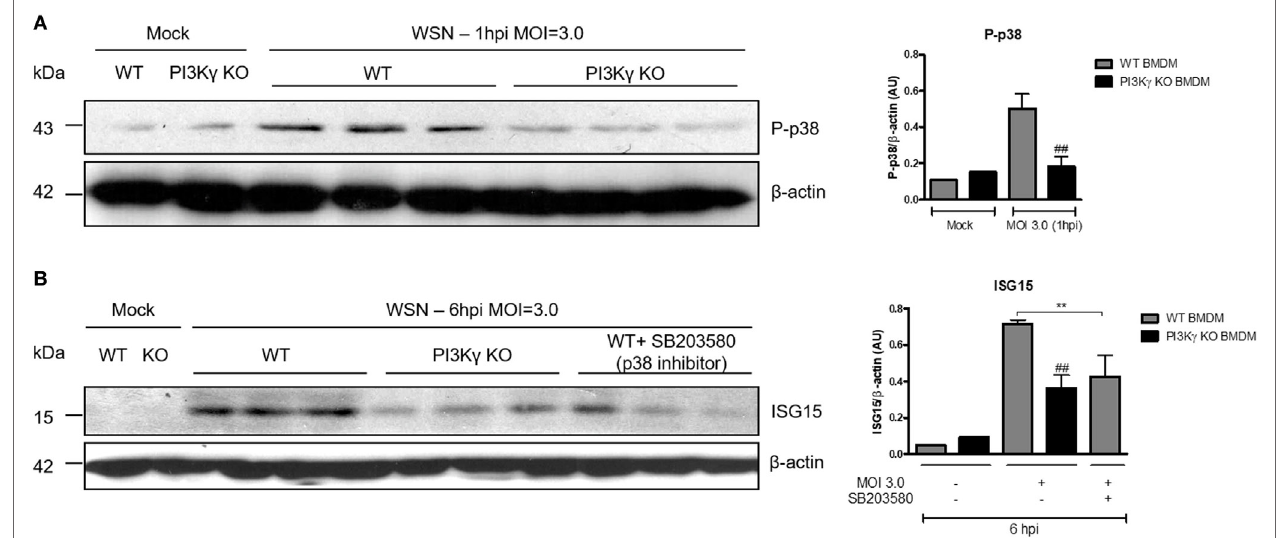
FigUre 4 | Phosphatidyl inositol 3 kinase-gamma (PI3K γ ) activation on bone marrow-derived macrophages (BMDM) leads to interferon-stimulated gene 15 (ISG15) production during influenza A virus infection in a p38-dependent way. BMDM from WT and PI3K γ knockout (KO) were infected with influenza WSN [multiplicity of infection (MOI): 3.0]. (a) One hour after infection, BMBM protein extracts were analyzed for p38 phosphorylation; β -actin was a loading control. (B) WT BMDM were pretreated with the p38 inhibitor SB203580 or vehicle and KO BMDM were treated with vehicle then infected with WSN (MOI: 3.0). ISG15 protein expression was assessed at 6 h after infection; β -actin was a loading control. Results are presented as mean ± SD. ** p < 0.01, when comparing WT-infected cells treated or not with SB203580; ## p < 0.01, comparing PI3K γ KO to WT infected BMDM (one-way ANOVA, Newman–Keuls).